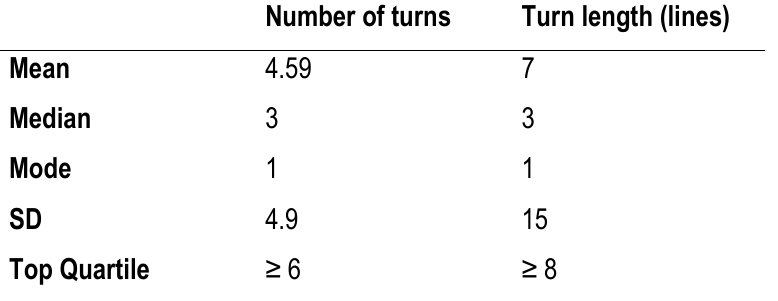
Statistical Descriptions of Participation in a Public